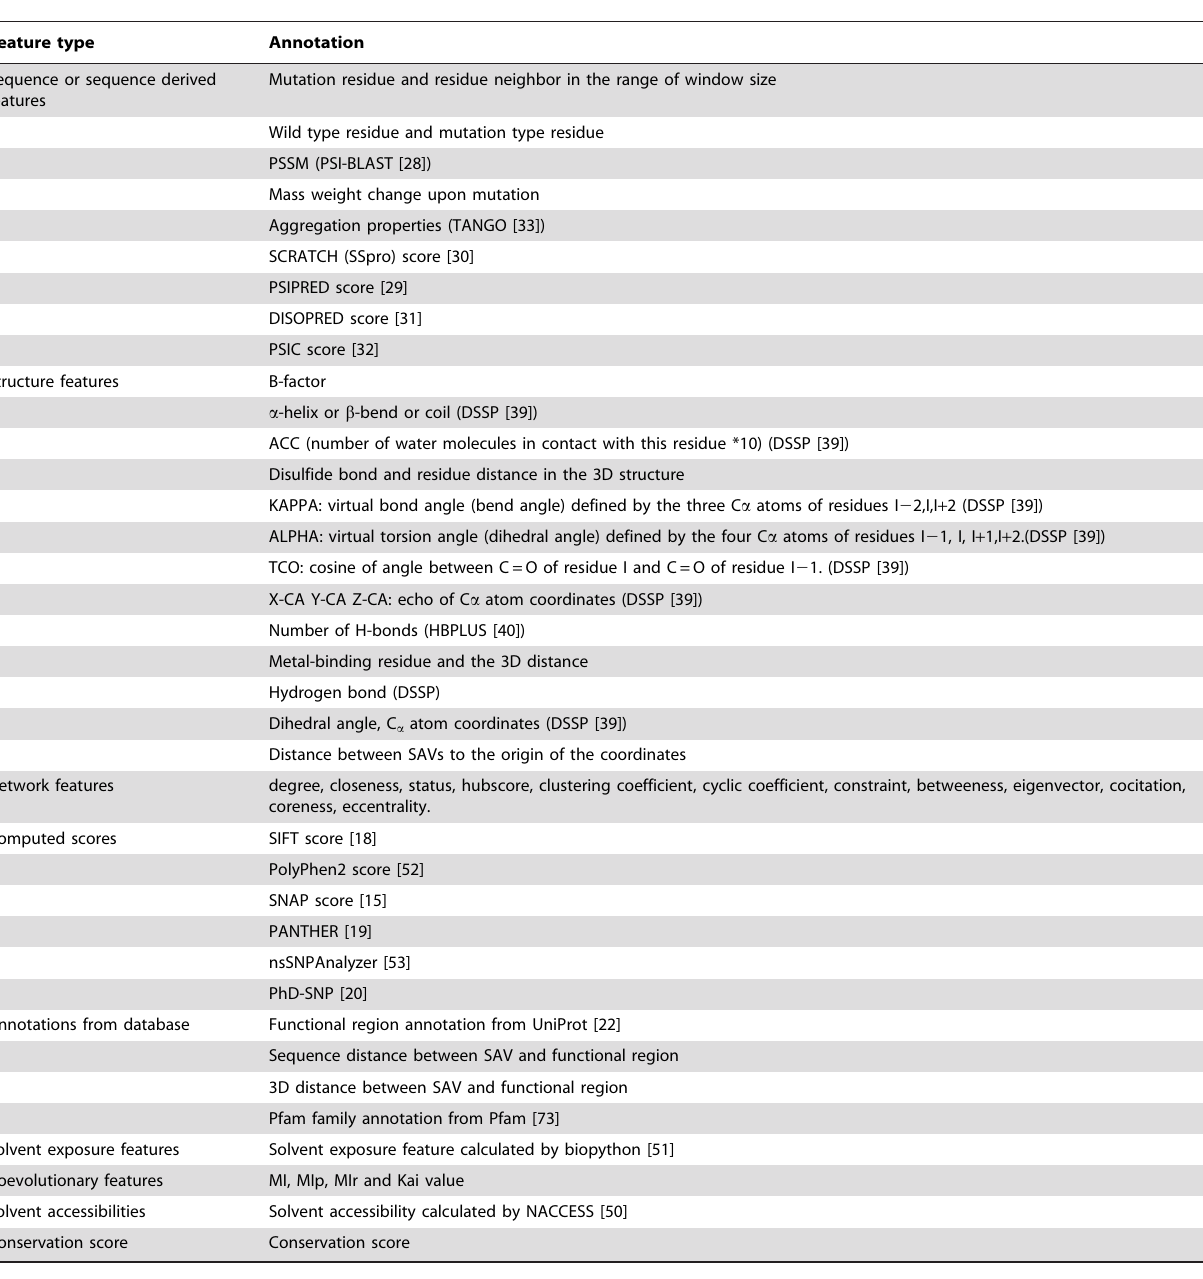
Table 1. Features used in this study, which are categorized into nine major types: sequence or sequence-derived, structure, residue-contact network features, computed scores, annotations from database, solvent exposure features, coevolutionary features, solvent accessibilities and conservation